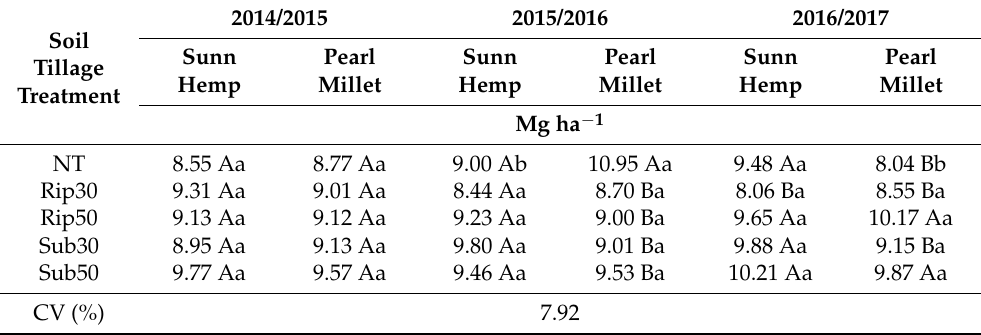
Table 5. Grain yield of maize grown on sunn hemp and pearl millet cover crop residues under different soil tillage treatments in three consecutive crop